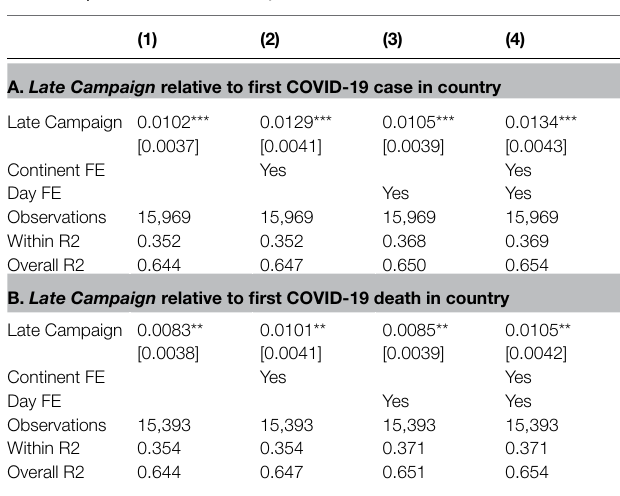
TABLE 1 | Main results from Study